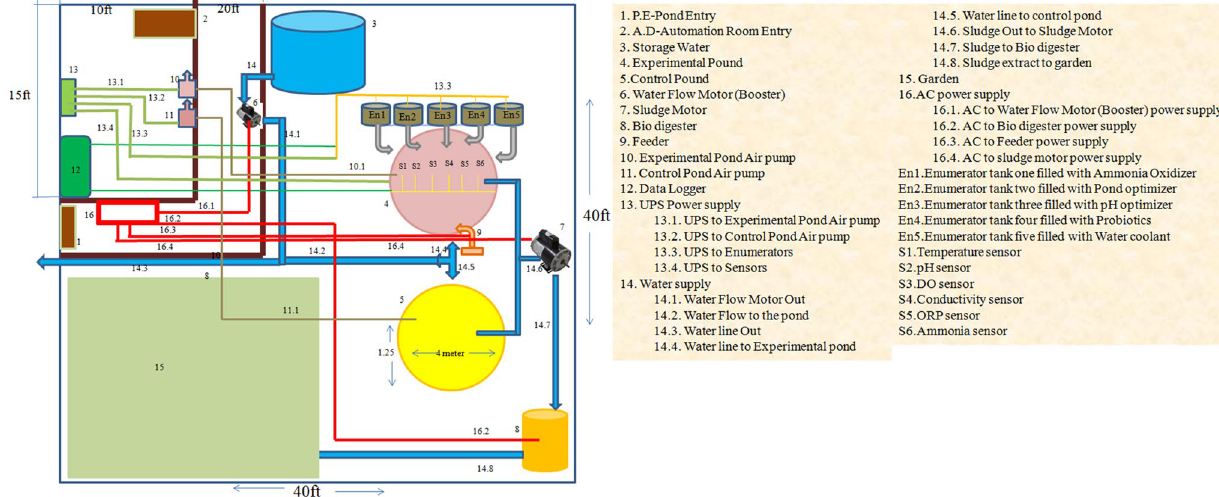
Fig. 1 Schematic representation of aquaculture automation designing for Biofloc production of